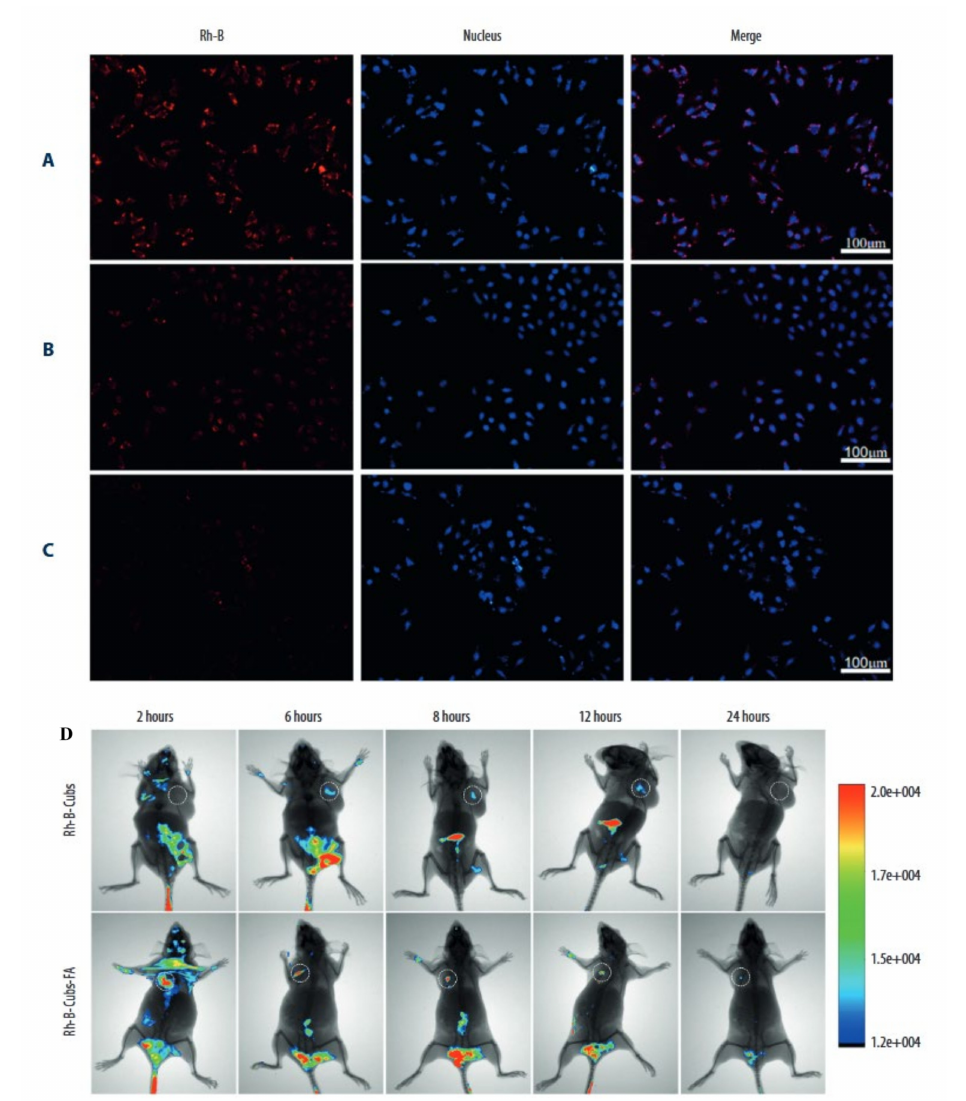
Figure 6. Rhodamine B (Rh-B) uptake by MCF-7 and in vivo tumor-targeting properties in mice bearing MCF-7 xenografts: ( A ) uptake of Rh-B; ( B ) uptake of Rh-B-Cubs; and ( C ) uptake of Rh-B- Cubs-FA at 4 h in MCF-7 cell lines; ( D ) whole-body and tumor fluorescence images (white circles indicate the inoculated tumor) in MCF-7 tumor-bearing mice after intravenous injection of Rh-B-Cubs and Rh-B-Cubs-FA. Source: Adapted from